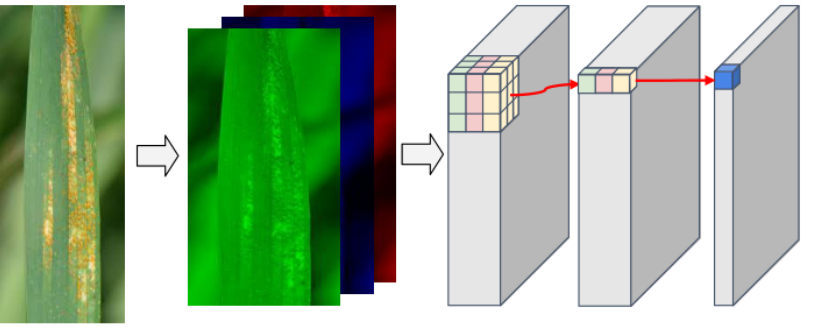
Figure 4. The information in the three channels of the RGB image enters the convolution layer, and after the convolution operation, the final feature map is